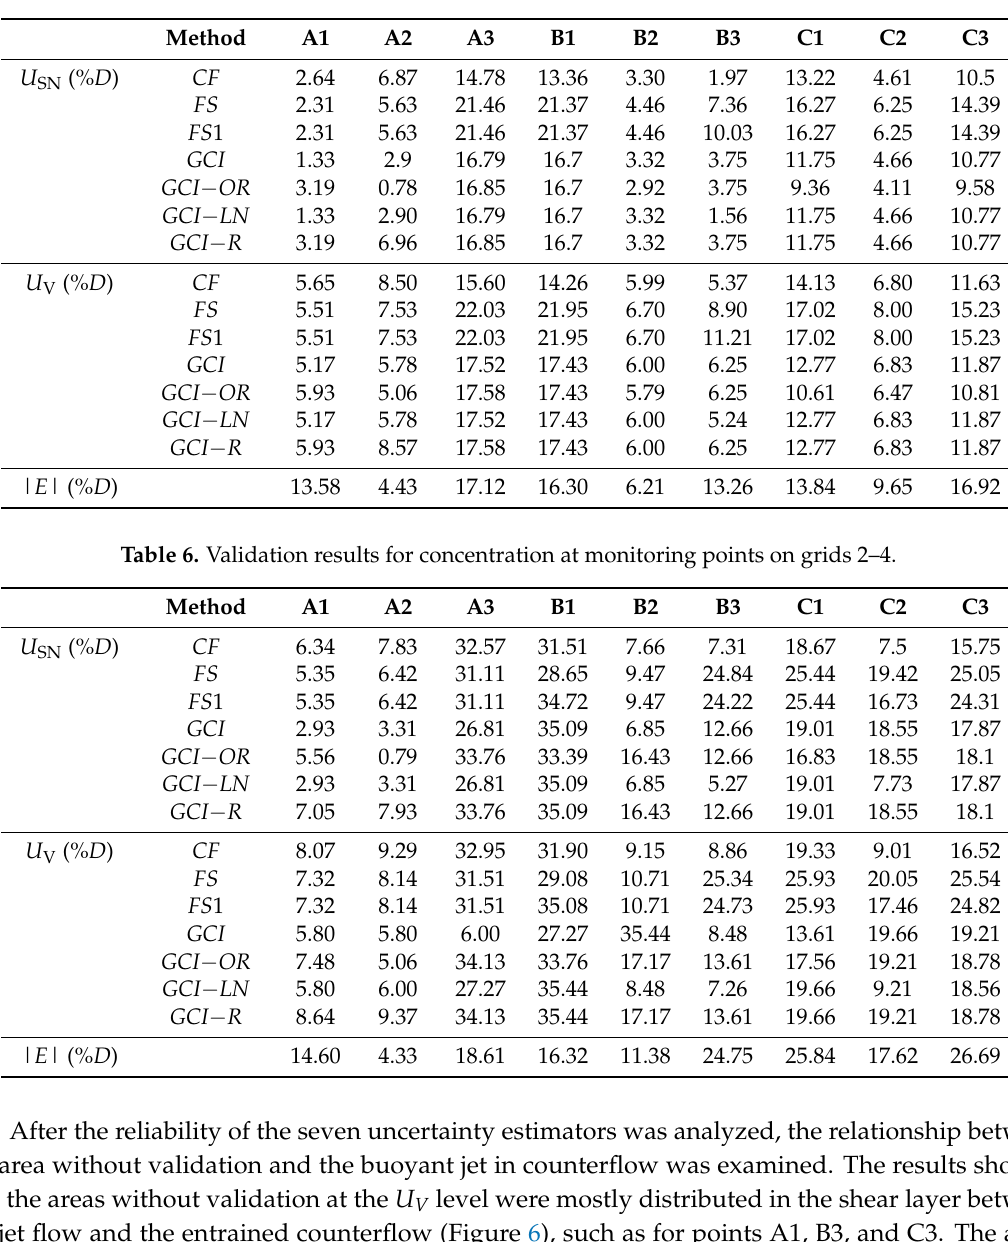
Table 5. Validation results for concentration at monitoring points on grids 1–3.